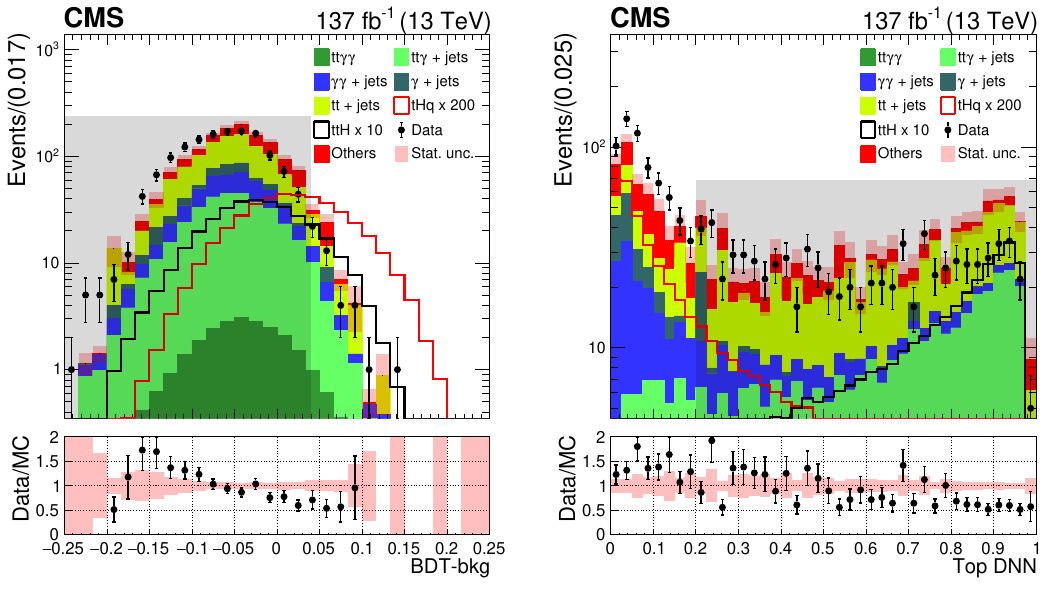
Figure 10 . Distributions of tHq BDT-bkg score (left) and the top DNN (right), which are used together to define the tHq leptonic analysis category. Events are taken from the m sidebands, gg satisfying either 100 < m < 120 GeV or 130 < m < 180 GeV. The statistical uncertainty in the gg gg background estimation is represented by the pink band. The regions shaded grey contain BDT-bkg and top DNN scores below and above the respective thresholds for the tHq analysis category. The full data set collected in 2016–2018 and the corresponding simulation are